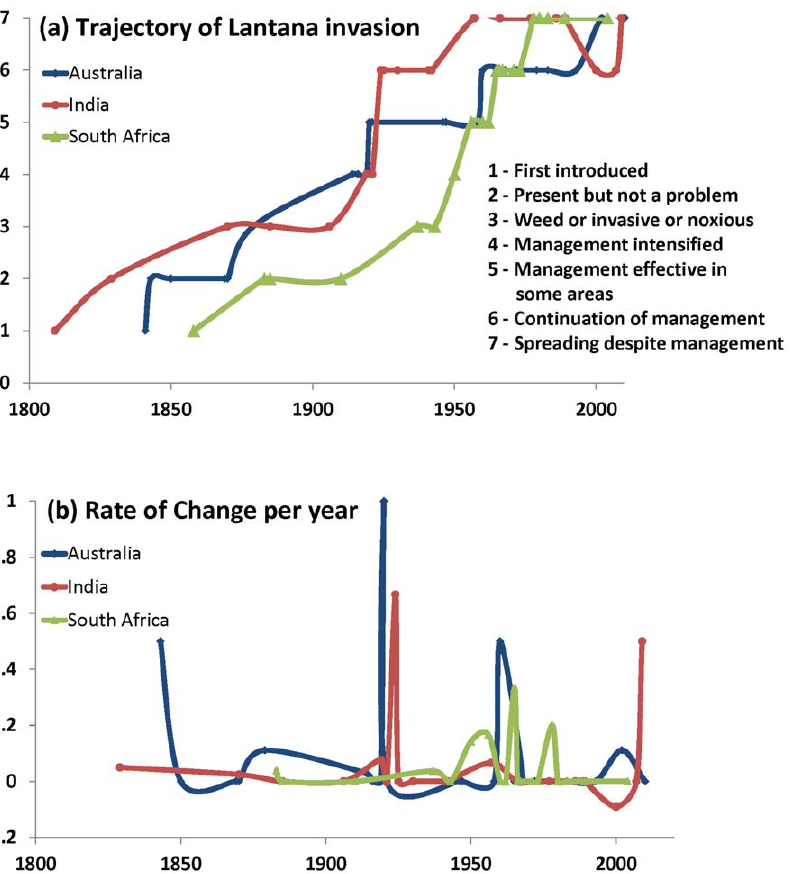
Figure 2. Invasion trajectories of Lantana in Australia, India and South Africa. ( a ) Historical records of Lantana spread, control and management are scored on a scale of 1–7: (1) first introduced; (2) present, but not a problem; (3) considered weed, invasive or noxious plant; (4) management intensified; (5) management reported effective in some areas; (6) continuation of same management strategy; (7) Lantana seen to be spreading in spite of management. ( b ) Rate of change is calculated as increase per year in the state of invasion, measured on the seven-point scale.